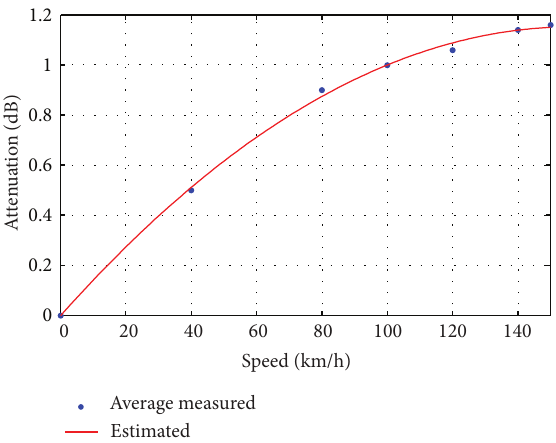
Figure 8: Signal losses with respect to satellite terminal